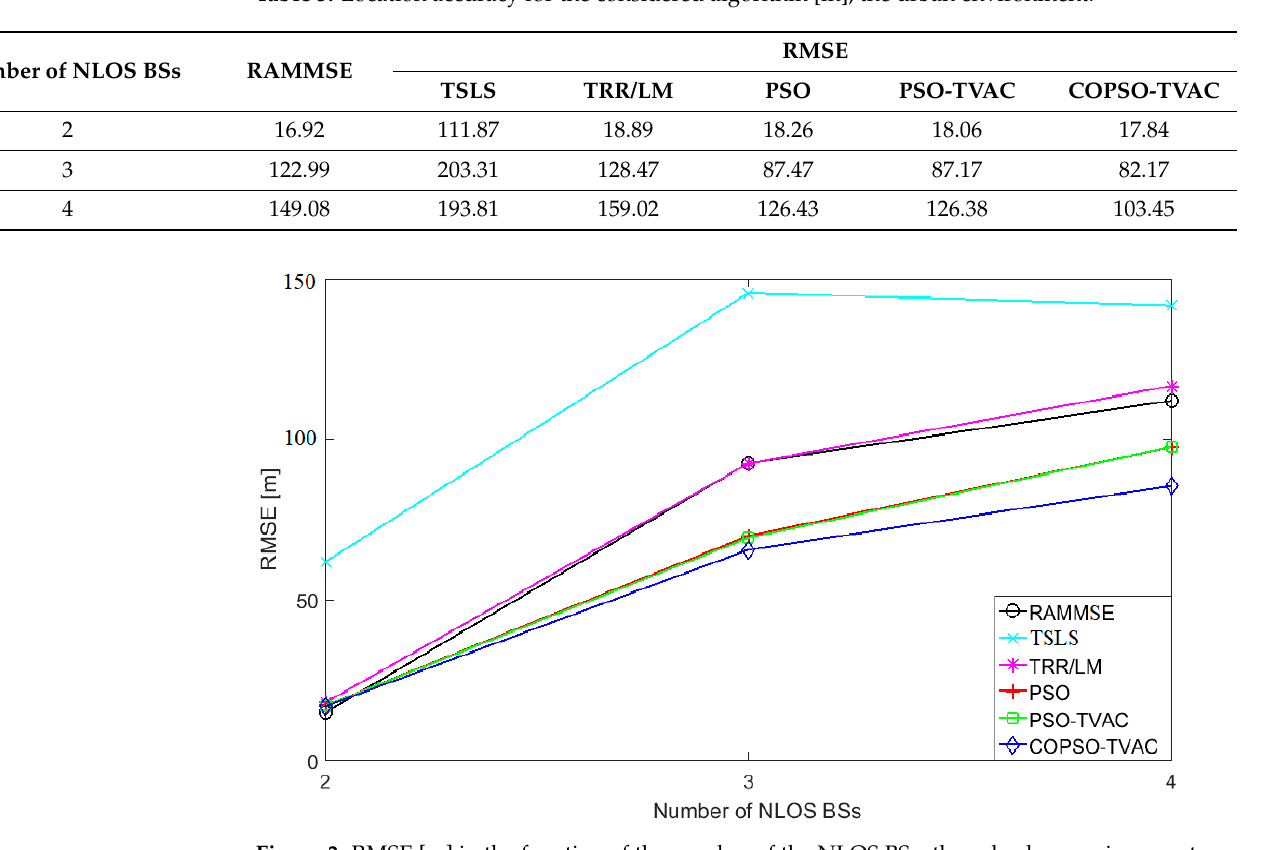
Figure 3. RMSE [m] in the function of the number of the NLOS BSs: the suburban